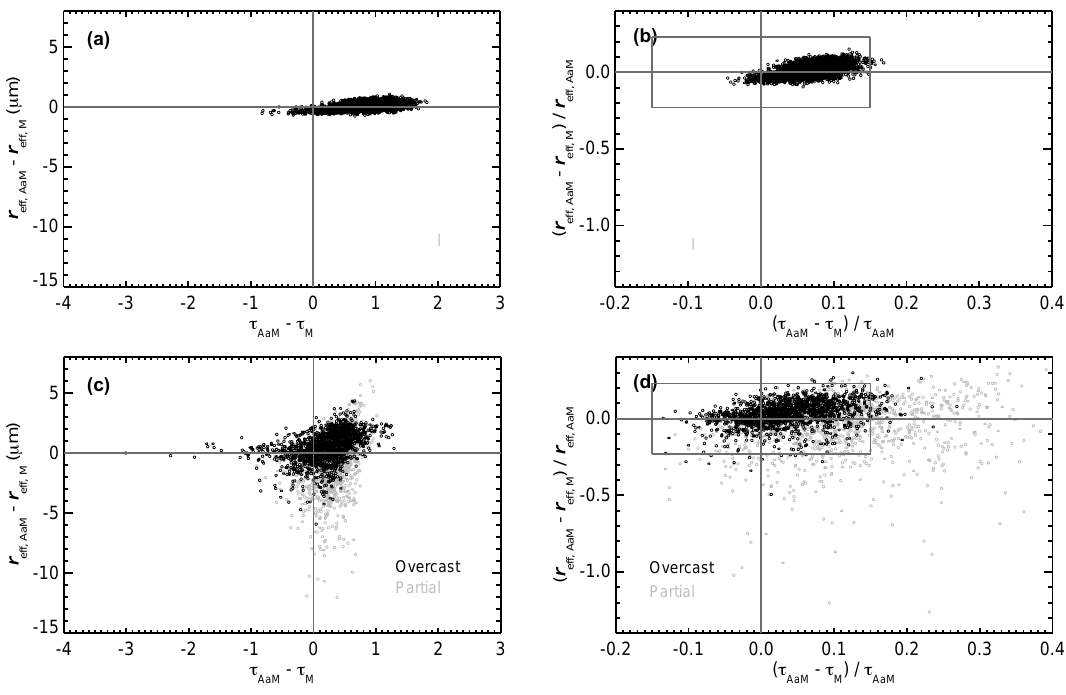
Figure 11. (a) Difference between effective droplet radius retrieved from co-located ASTER observations ( r eff , aA ) and the operational MODIS product ( r eff , M ) versus difference between cloud optical thickness retrieved from co-located ASTER observations ( τ aA ) and the operational MODIS product ( τ M ). Only data points where both ASTER and MODIS retrievals have a successful liquid water cloud retrieval are shown. Colors indicate samples over overcast (black) and partially cloudy pixels (gray). The gray horizontal and vertical lines indicate the points where no deviation between ASTER and MODIS retrievals occur. Data are from observations on 13 May 2003 (C14). (b) Same as (a) but normalized by r eff , aA and τ aA , respectively. The gray box indicates the mean retrieval uncertainty for r eff , aA and τ aA , calculated by applying the absolute radiometric uncertainties of ASTER band 3N and 5 reflectances. (c) – (d) Same as (a) – (b) but for observations on 10 June 2005